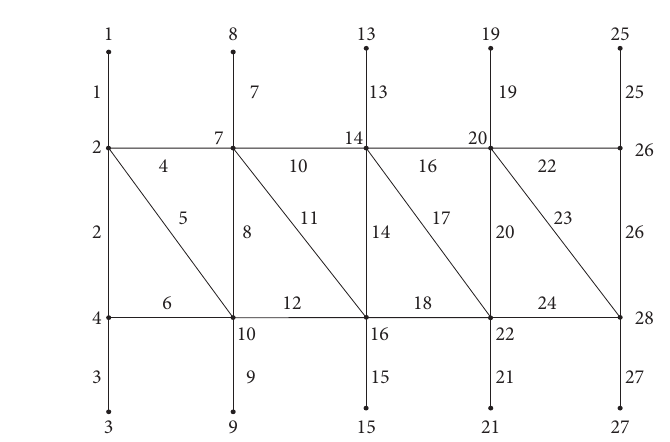
Figure 9: A classical mean labeling of TL